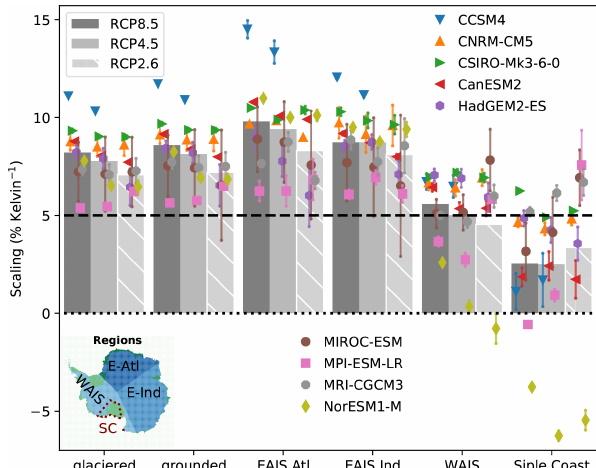
Figure 5. Air temperature–precipitation scaling deduced for the nine CMIP5 models (Table 1) and three future scenarios (legend) in six defined regions in Antarctica (see the map in the lower-left corner and Table 5). The coastlines and the grounding line posi- tions are deduced from Fretwell et al. (2013). The gray bars repre- sent the CMIP5 data set average, and the individual symbols stand for CMIP5 models. Here, the results apply for both reference peri- ods, where the anomalies are computed relative to the first or last 50 years of piControl. Each symbol is the model average of both reference periods, and the attached line indicates the scatter range between the first and last 50-year reference periods. Note that the RCP2.6 scenario does not include the CCSM4 model; hence, the corresponding bar is